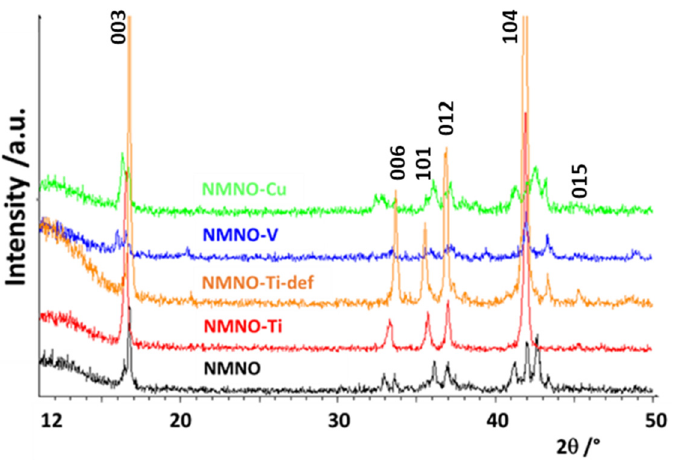
Figure 1. XRPD patterns of pure and doped samples. The Miller indices of the main reflections of the O3 polymorph are also reported.